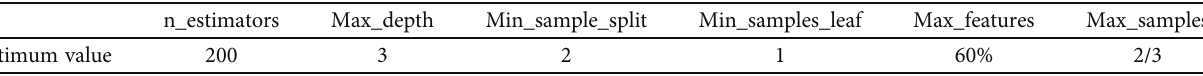
Figure 12: The schematic of the cross-validation method. Table 5: Optimized hyperparameter settings of the random forest algorithm.